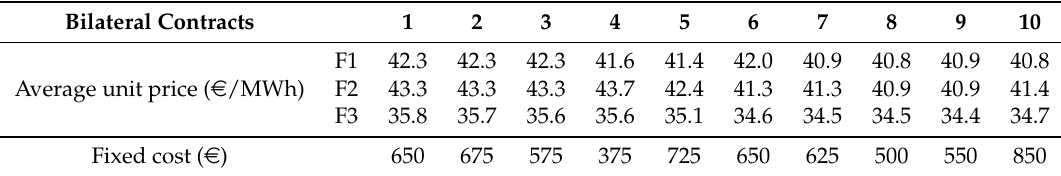
Table 1. Available bilateral contracts.